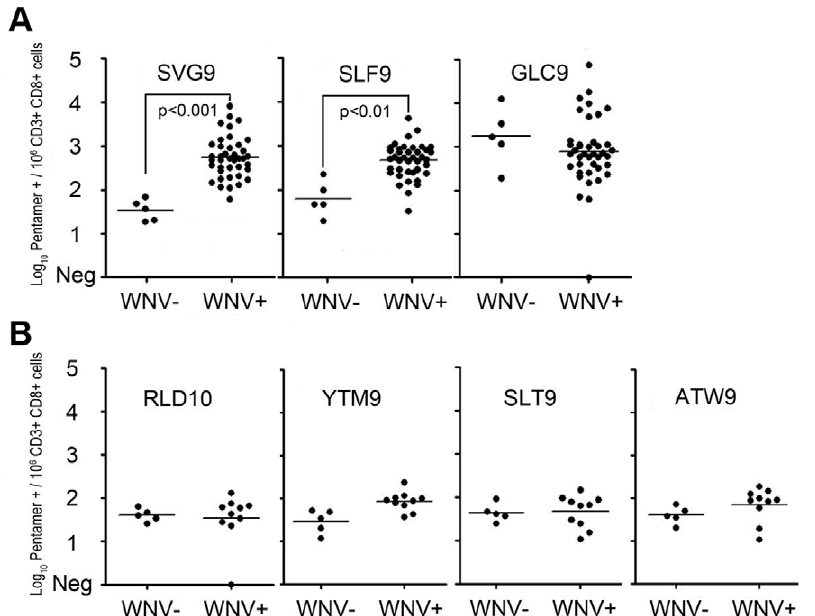
Figure 1. WNV p-MHC multimer positive T cells are recognized at high frequency in seropositive subjects. Log 10 frequency of p-MHC multimer positive events per 10 6 CD3 + /CD8 + cells from WNV seropositive and WNV seronegative subjects are shown for (A) dominant epitopes and (B) non dominant WNV epitopes. All comparisons were made using a one-way ANOVA with a Tukey post-hoc test. In all cases, lines represent mean values.